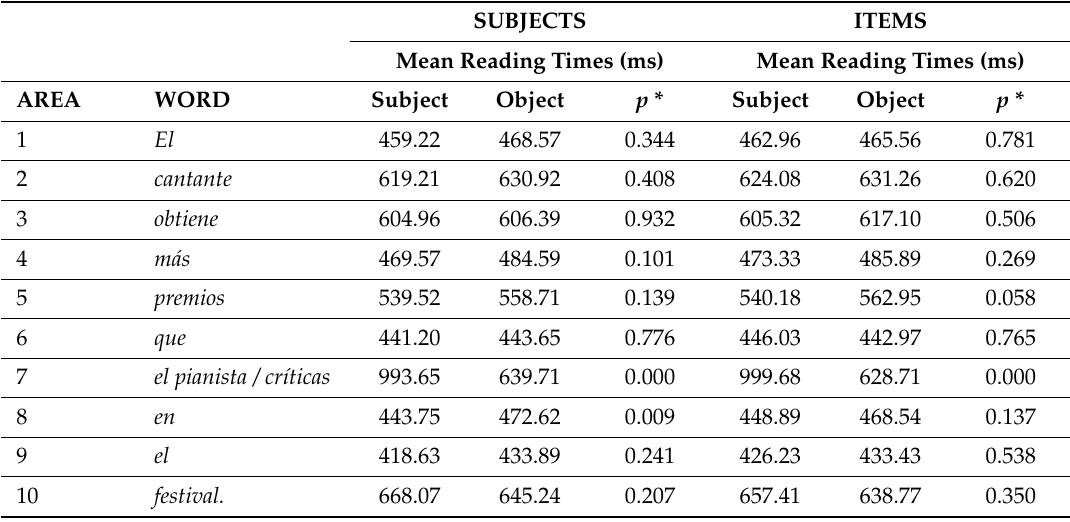
Table 3. Reading times of Type of Continuation with raw data in